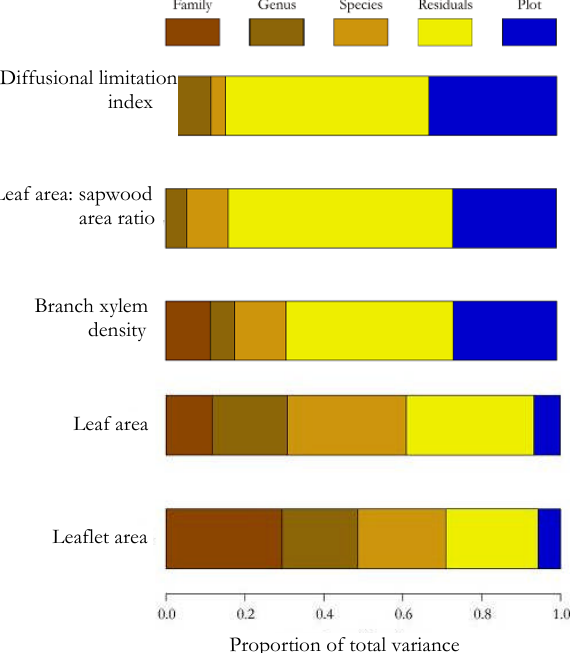
Fig. 2. Partitioning of the total variance for each studied property into taxonomic (family/genus/species), environmental (plot) and er- ror (residual) components. Traits are sorted from less to more tax- onomically constrained. Significance of each variance component was tested with a likelihood ratio test (Galwey, 2006). Significance codes: *** < 0 . 001, ** < 0 . 01,* < 0 .